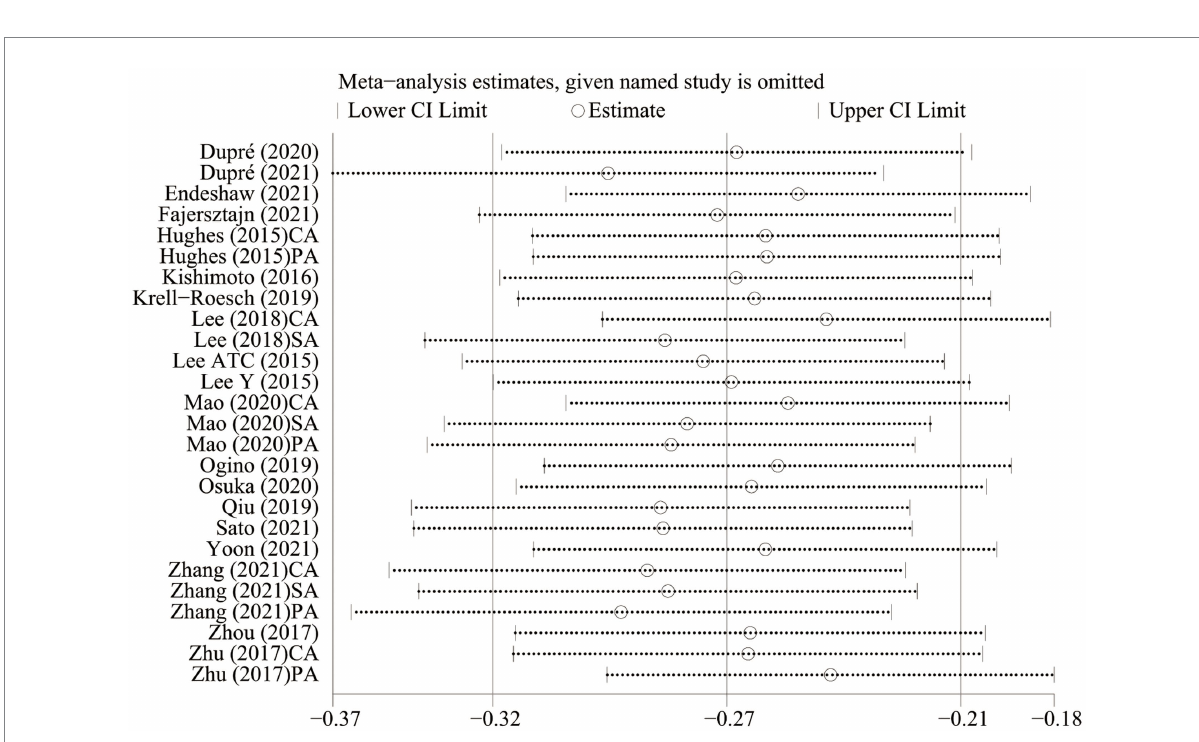
FIGURE 4 Plot of sensitivity analysis by excluding one study each time and the pooling estimate for the remaining studies. CA, cognitive activity; SA, social activity; PA, physical